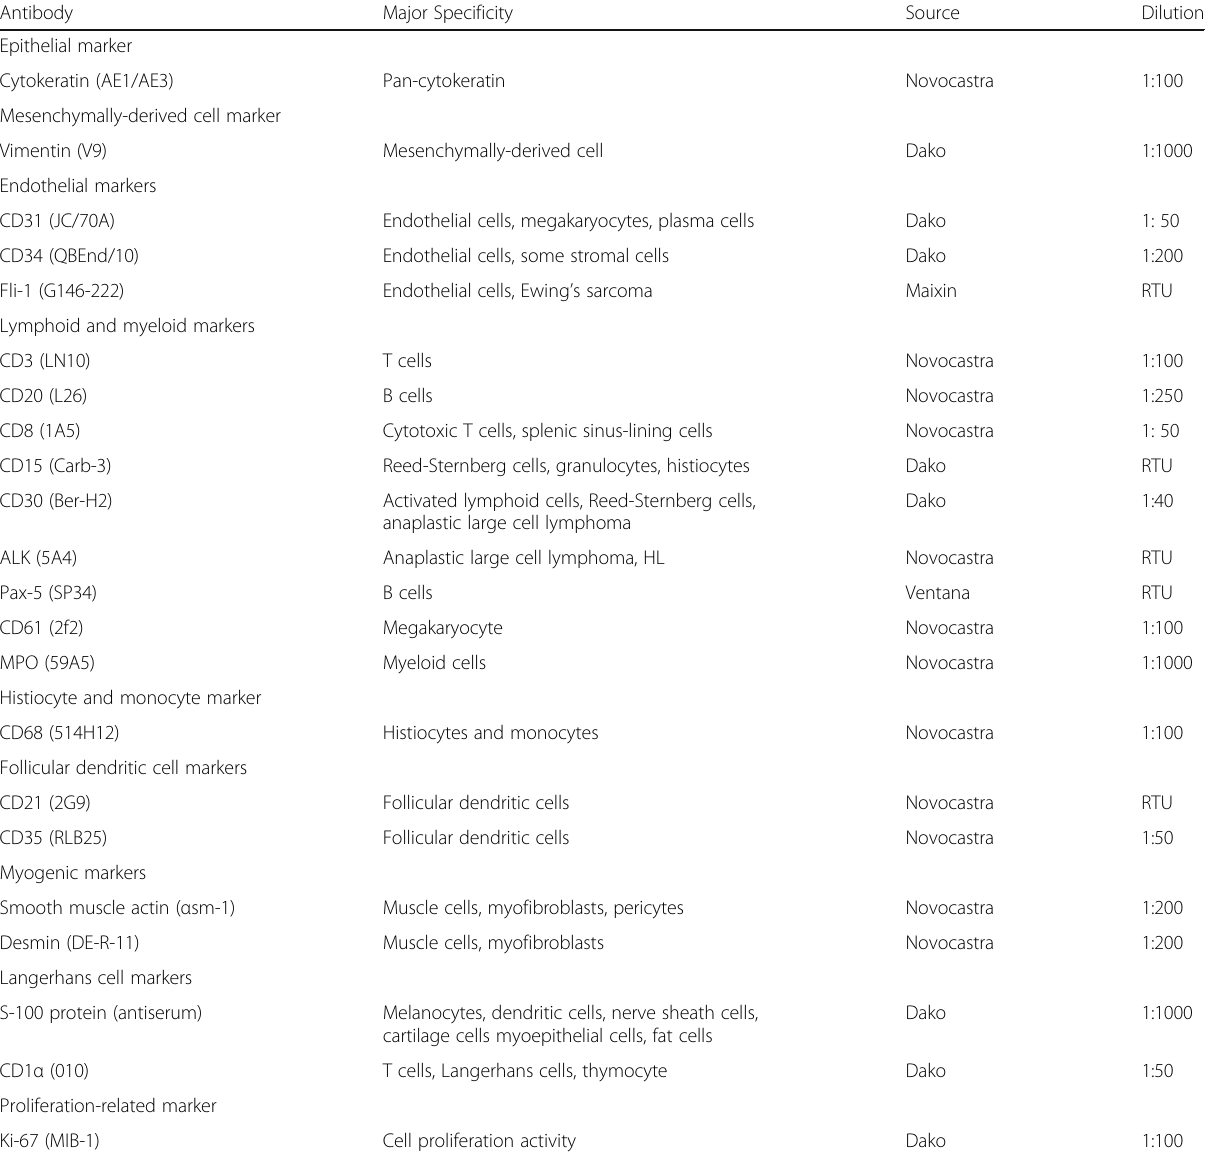
Table 1 Antibodies used for immunohistochemical staining Antibody Major